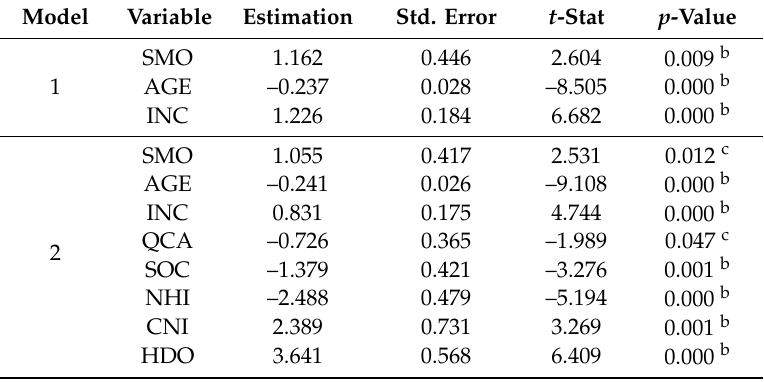
Table 3. Coe ffi cients a and p -values for linear regression (LR)